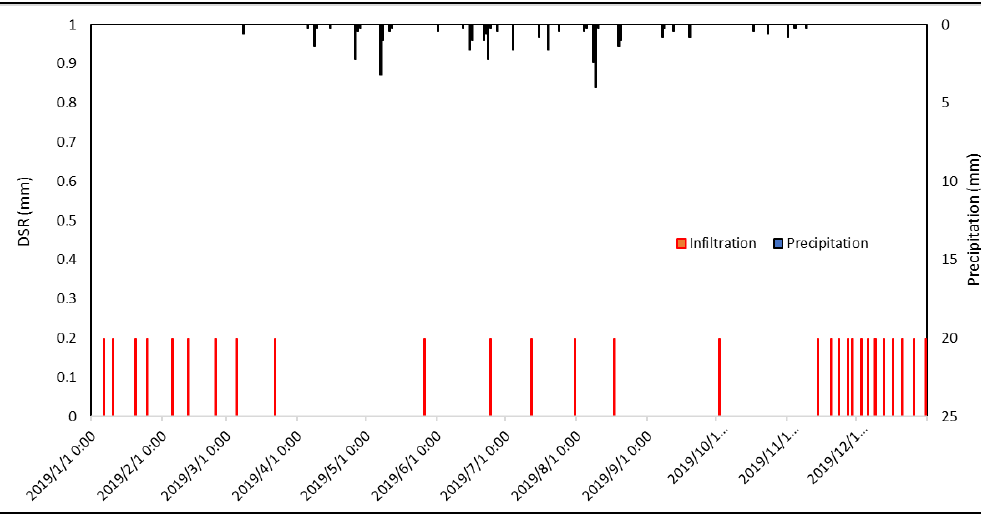
Figure 9. Relationship between precipitation and DSR in 2019 .